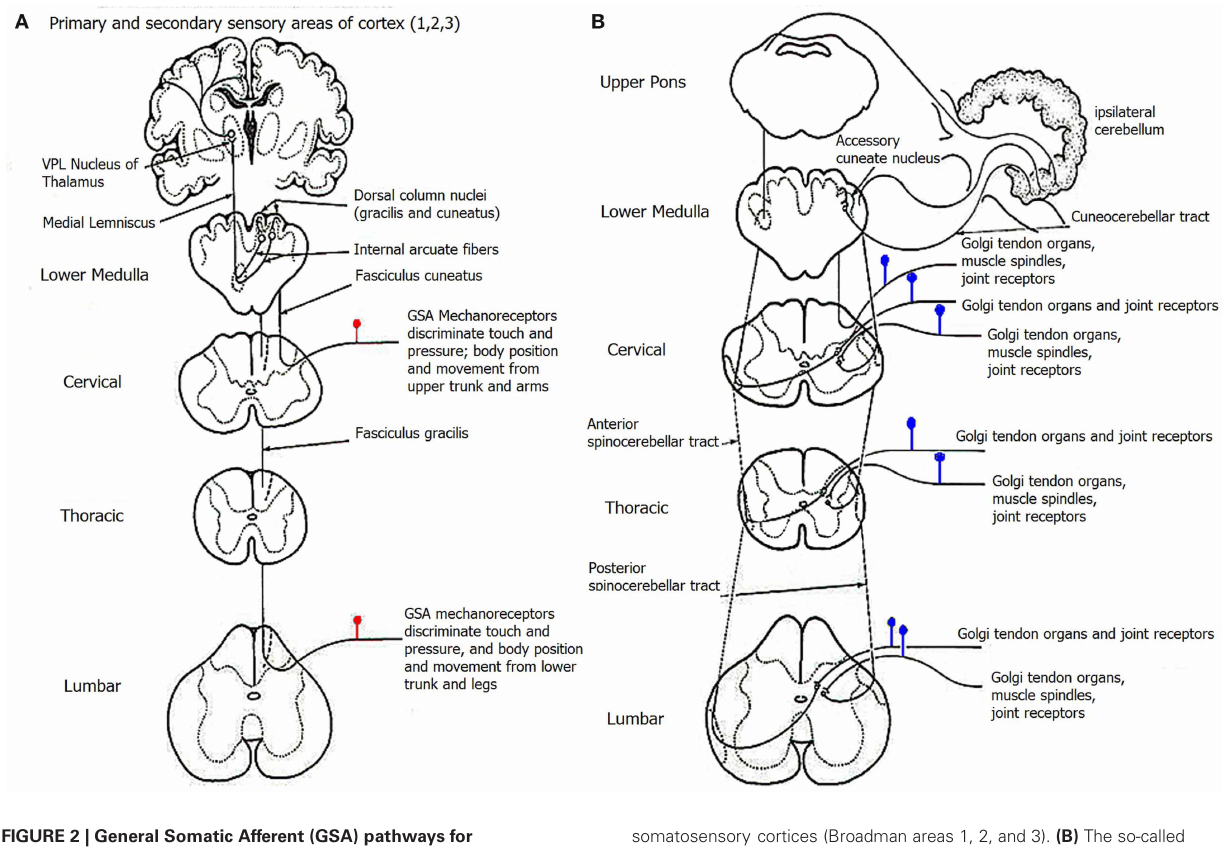
FIGURE 2 | General Somatic Afferent (GSA) pathways for proprioception. (A) The so-called conscious proprioception conveying information about touch and pressure and body position and movement through the GSA mechanoreceptors sensitive to discriminating among various levels of the input patterns. Synapses at several points conduct information via the thalamic relay station onto the primary and secondary